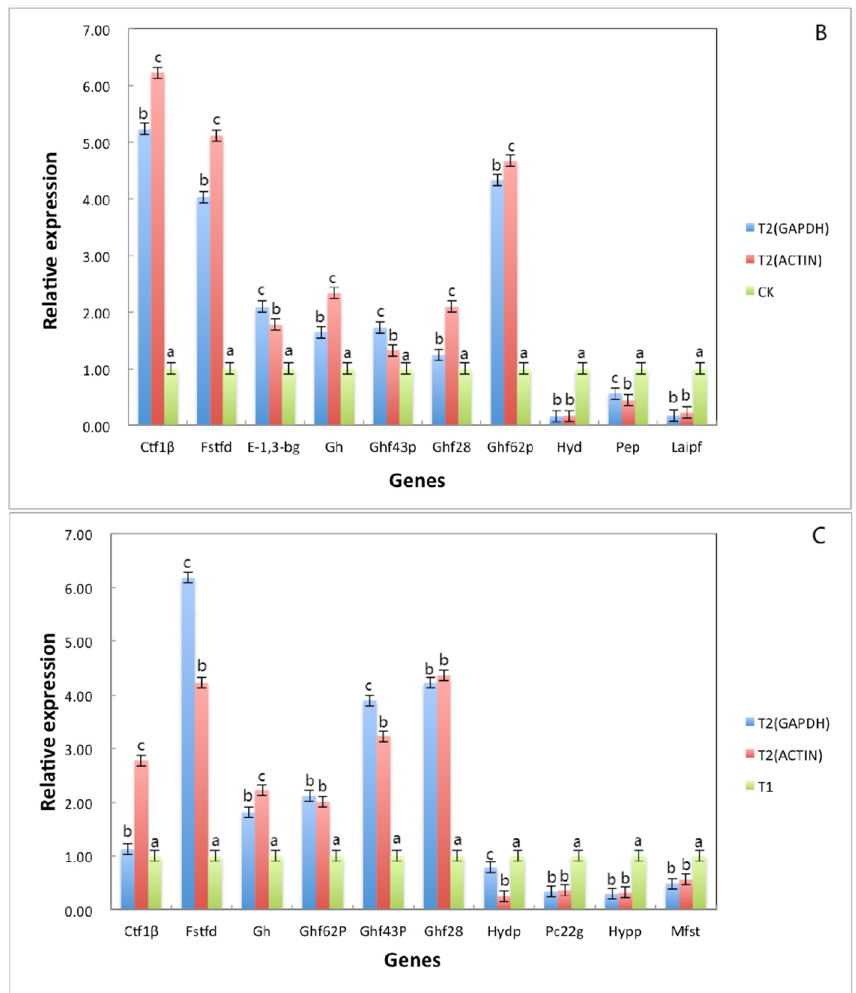
Figure 7. The differential gene expression under different treatment conditions was verified by fluorescence quantitative analysis. Note: ( A ) refers to the detection results of 10 differential gene expressions under two different culture conditions of sterile deionized water and sterile rice tissue fluid; ( B ) refers the detection results of 10 differential gene expressions under two different culture conditions of sterile deionized water and sterile tissue fluid of B. pervariabilis × D. grandis ; ( C ) refers the detection results of 10 differential gene expressions under two different culture conditions of sterile rice tissue fluid and sterile B. pervariabilis × D. grandis . tissue fluid. All assays were repeated three times, the data were analyzed using one-way ANOVA and Duncan’s range test in SPSS 16.0. Different lowercase letters showed that there were significant differences in the expression level of the same gene under different treatment conditions. Blue represents the relative expression after normalization with GAPDH as the reference gene. Red represents the relative expression after normalization with actin as the reference gene ( p ≤